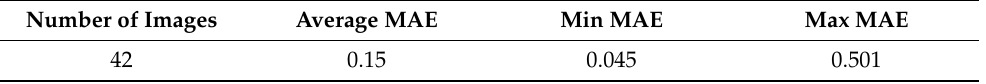
Table 10. Mean absolute error (MAE) of false-positive images in the Cityscapes dataset.